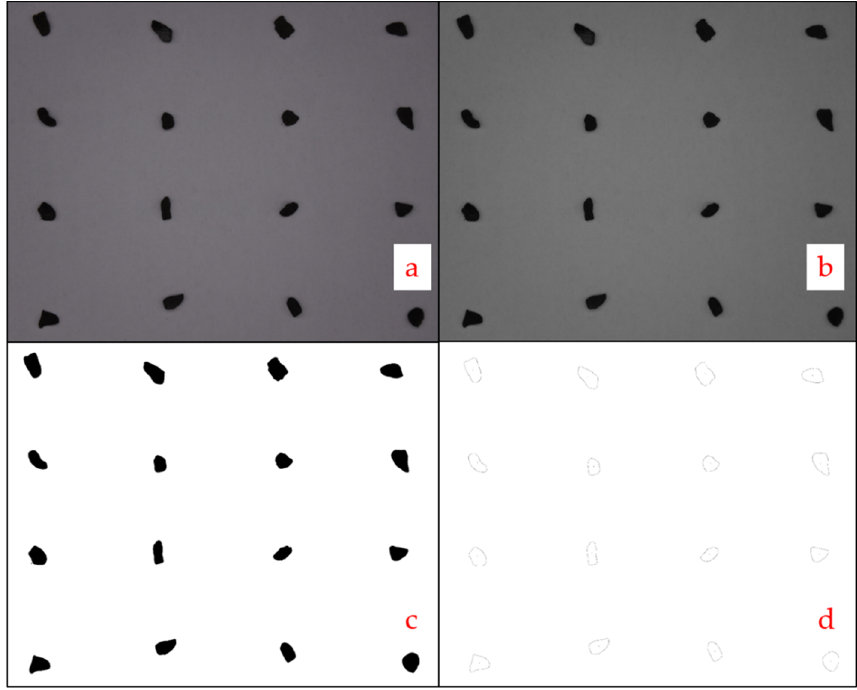
Figure 3. Examples of image conversion of shale cuttings: ( a ) Original RGB image; ( b ) Gray image; ( c ) Image threshold; ( d ) Drawing contour.